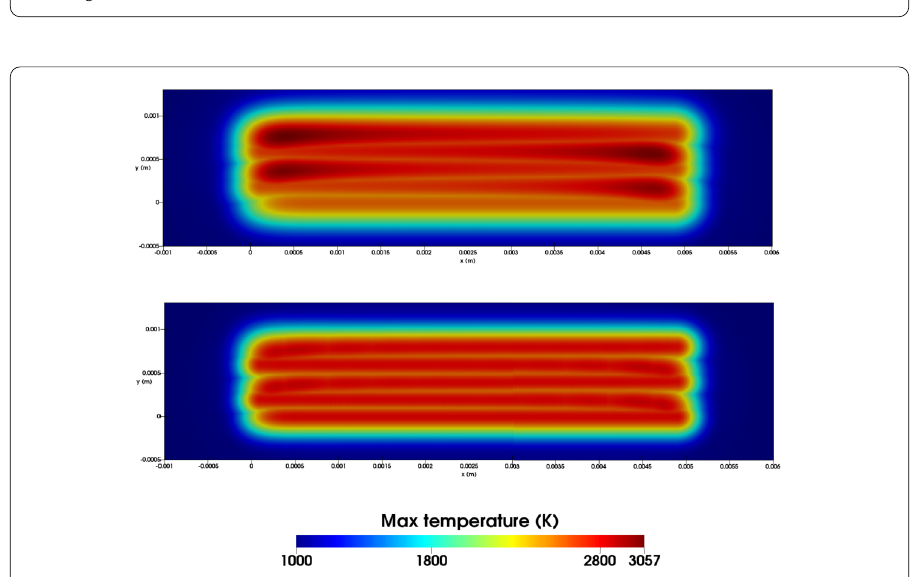
Figure 7 A comparison between maximum temperatures on the surface ( z = 0) before optimization (top) and after optimization. The optimization scheme resolves the heat accumulation at the turning